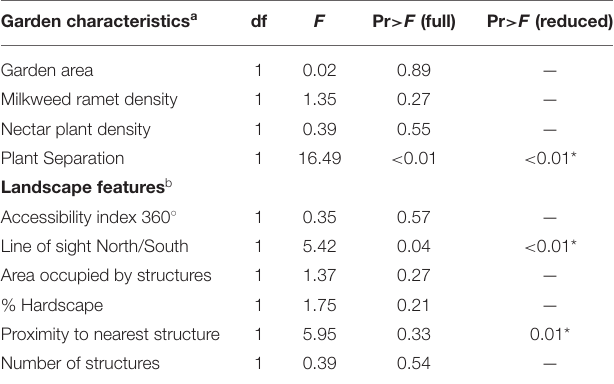
TABLE 1 | Summary of analysis of variance for the effects of garden characteristics and landscape features on the number of monarch eggs and larvae observed in